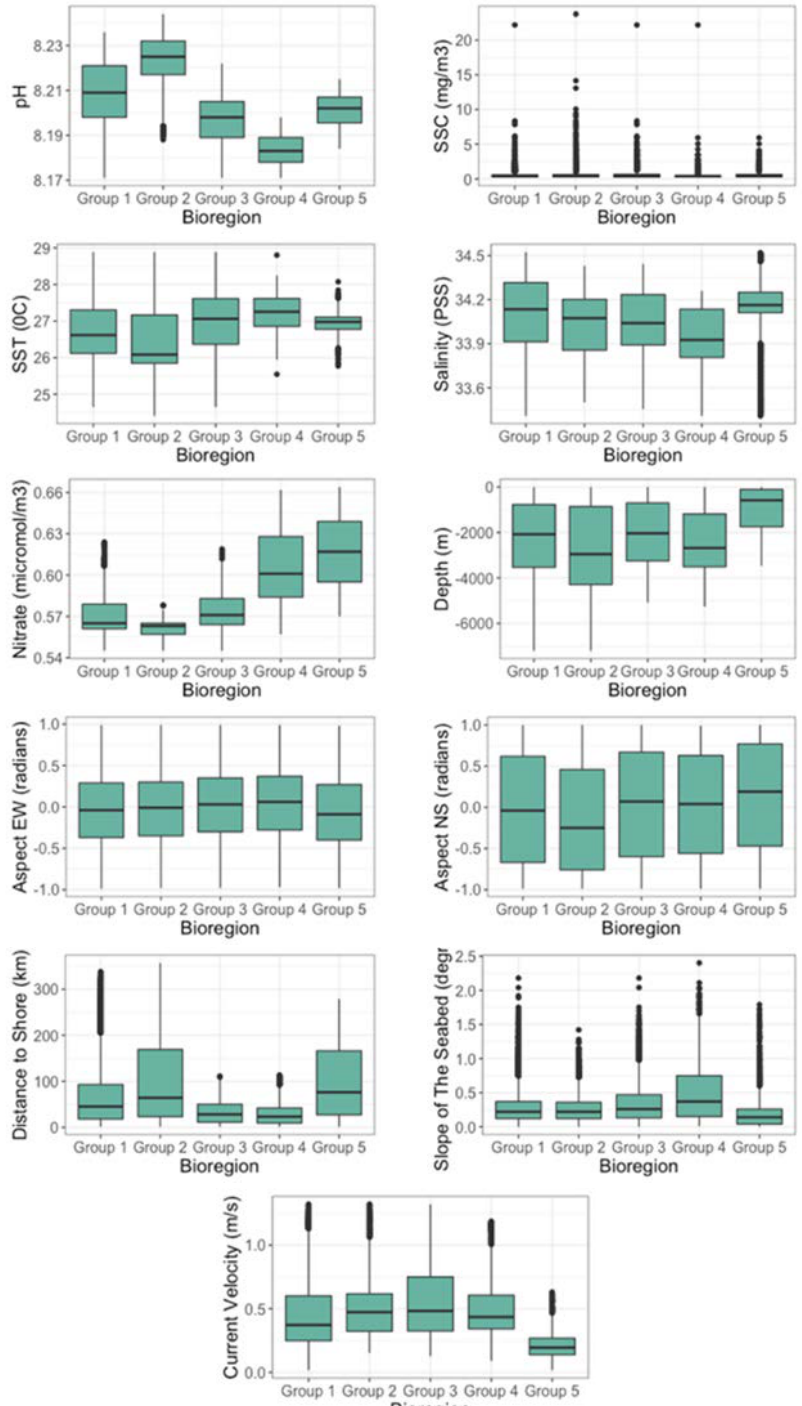
Fig. 5: Environmental characteristics of each FCM delineation group in the wet season